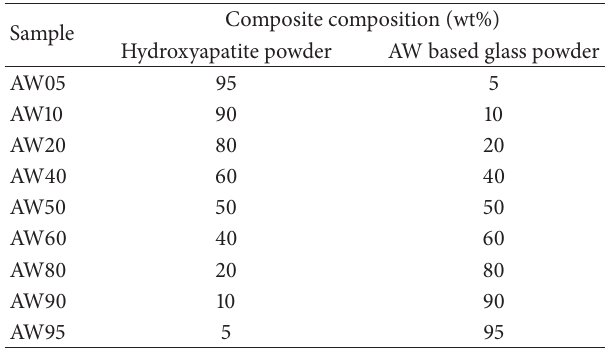
Table 1: Compositions of HA-AW